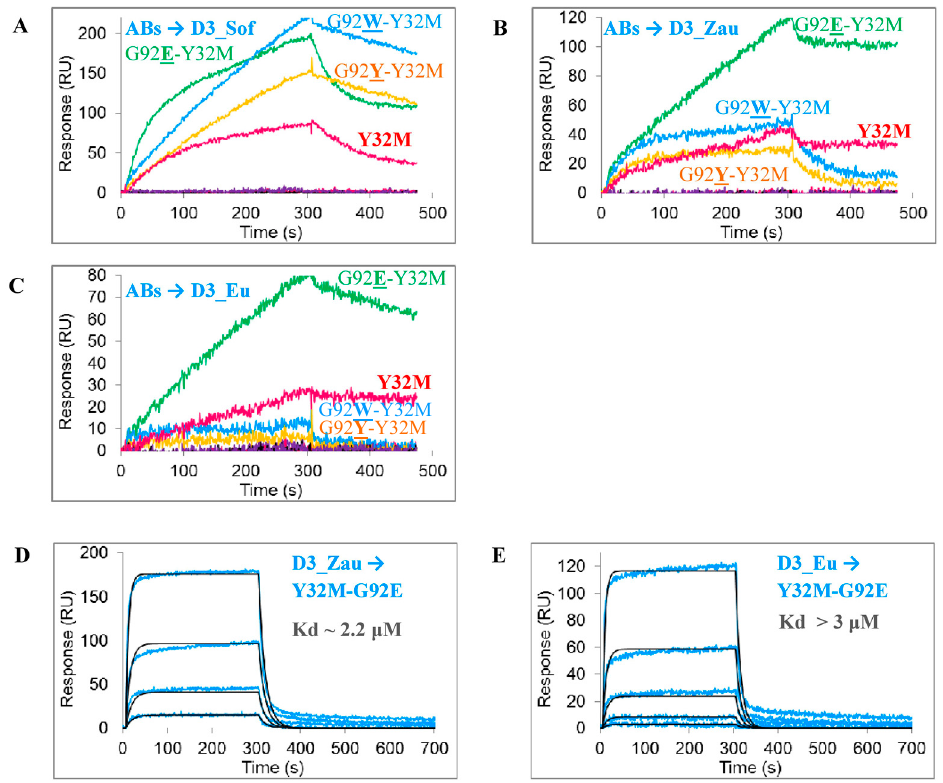
Figure 3. Binding of mutant antibody variants Y32M-G91F, Y32M-G91W, Y32M-G92E, Y32M-G92W, Y32M-G92Y, Y32M-G100W, Y32M-G100Y, and Y32M-A102W to D3 proteins: ( A–C ) E. coli periplasmic extracts containing antibody variants were used for screening at approximate antibody concentration of 100–200 nM (as estimated by the intensity of the corresponding bands on the gel electrophoregram). The G92F-Y32M antibody trace is shown in purple. ( D , E ) Measurement of affinity constants. Three- fold dilutions of purified D3 proteins were used starting from 3.24 µ M concentration. Experimental curves are shown by colored lines, approximations are shown in black. The analysis was carried out using a ProteOn XPR36